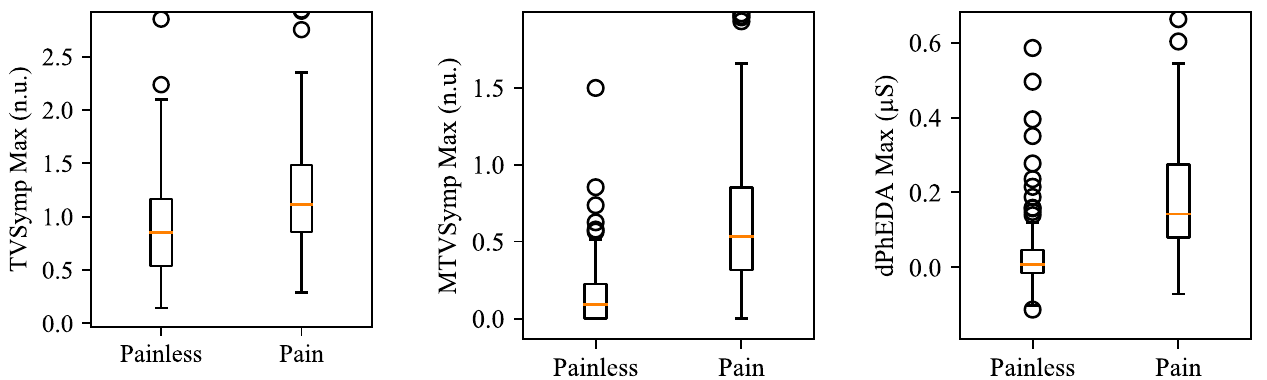
Figure 9. Boxplots for maximum values of TVSymp, MTVSymp, and dPhEDA for EP dataset. The circles in the boxplots indicate outliers. Outliers were set if each datum is above Q1 − 1.5 × (Q3 − Q1) or below Q3 + 1.5 × (Q3 − Q1). Q1 and Q3 represent the first and third quartiles, respectively. Table 4. Statistical analysis on difference between painless and pain segments for EP dataset.